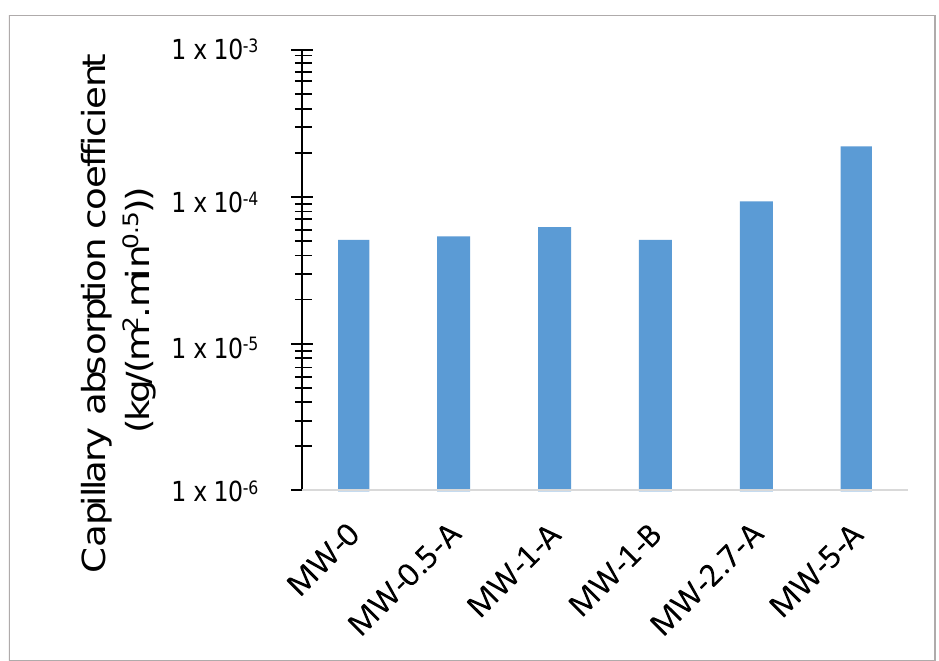
Figure 5. Water absorption for the different samples.